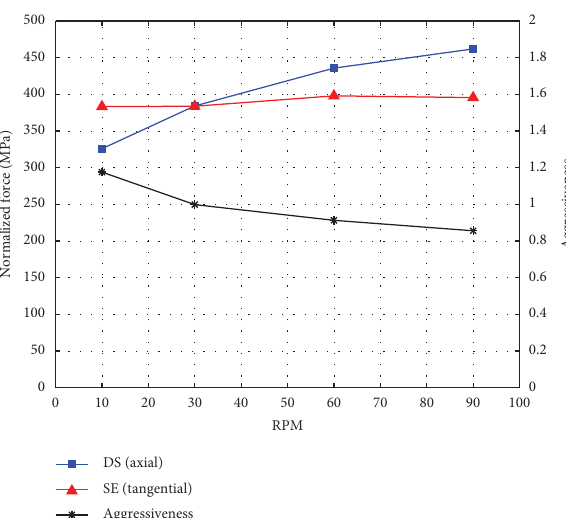
Figure 4: Evaluated drilling strength (DS), specifc energy (SE), and cutter aggressiveness.